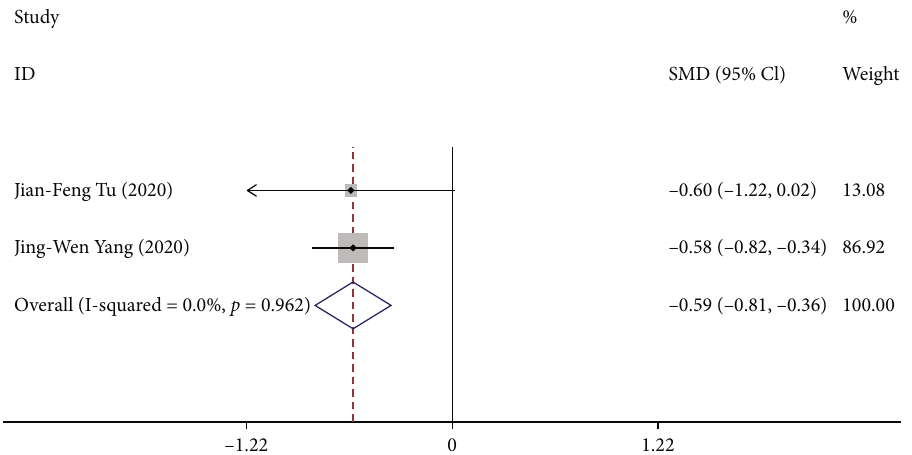
Figure 6: Forest plot of comparison. Acupuncture vs. sham acupuncture. Outcome: change in SID from baseline to week 16.